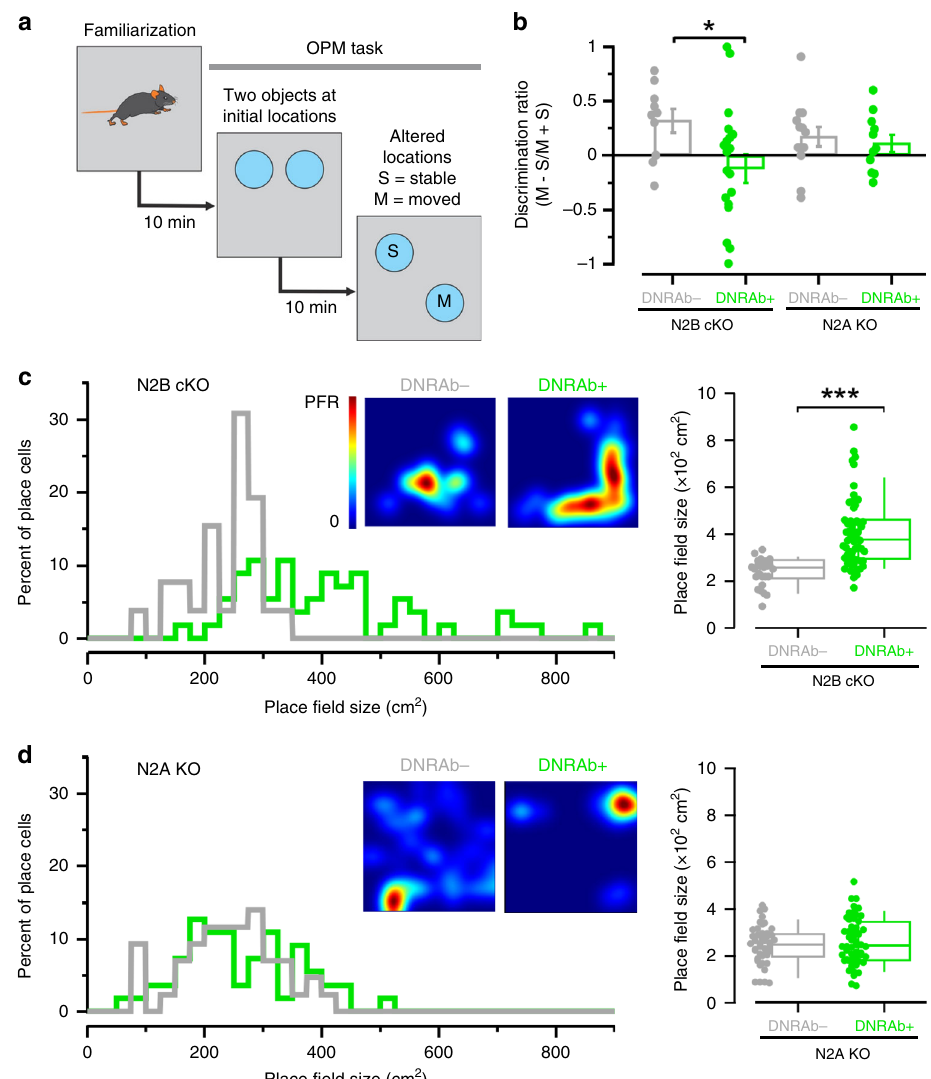
Fig. 5 Behaviors disrupted by DNRAbs persist in mice-lacking GluN2B, but not in those lacking GluN2A. a Schematic of the object-place memory (OPM) task. b DNRAb + N2B cKO mice show signi fi cantly reduced exploratory behavior, relative to its control, of the moved object over the stable